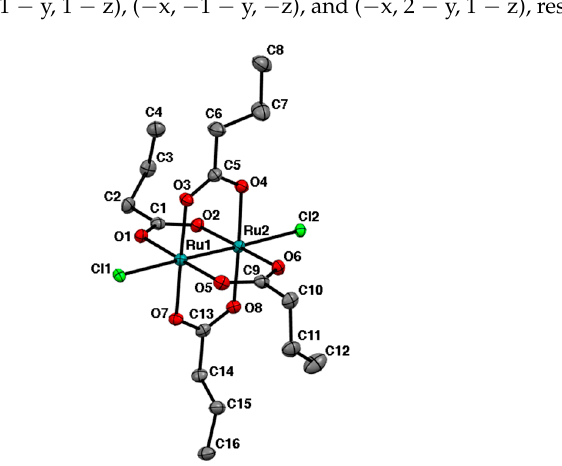
(cid:48) ), double primes ( (cid:48)(cid:48) ), and triple primes ( (cid:48)(cid:48)(cid:48) ) refer to the Magnetochemistry 2019 , 5 , x FOR PEER REVIEW Figure 1. Packing diagram of 2 . Primes ( ′ ), double primes ( ′′ ), and triple primes ( ′′′ ) refer to the Figure 1. Packing diagram of 2 . Primes (